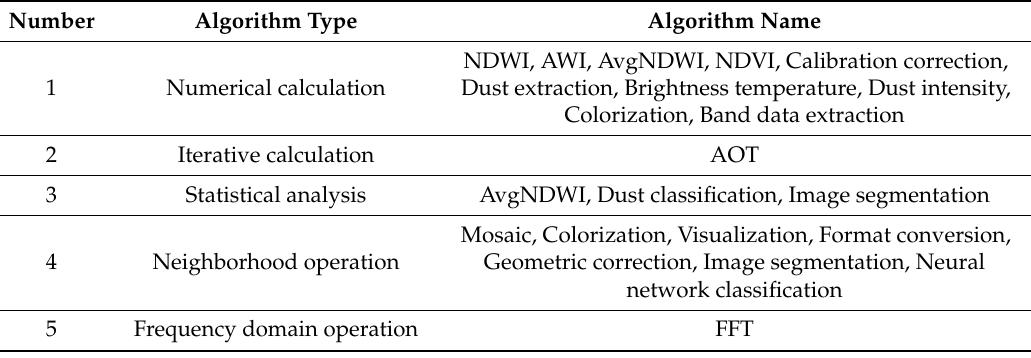
Table 2. The computational types of the algorithms included in the five typical disaster-monitoring